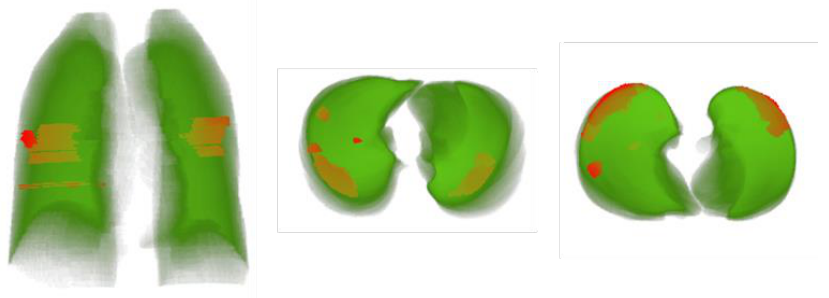
Figure 9. The proposed 3D lung models from different views whilst the infection area is marked in